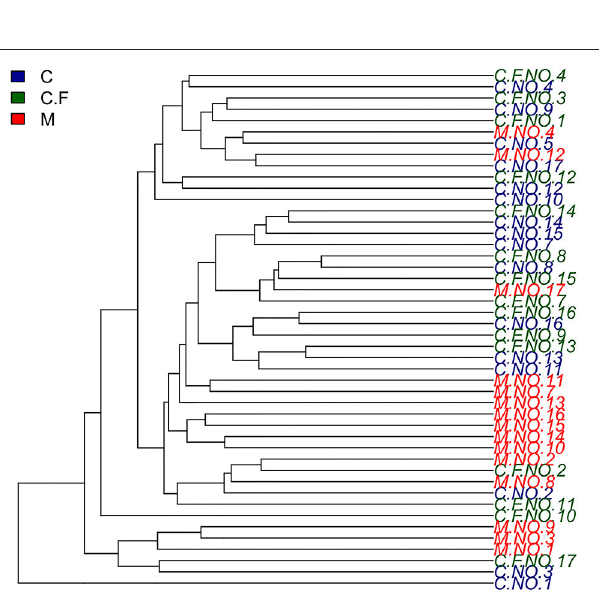
FIGURE 4 | Hierarchical cluster Analyses shows a similarity plot based on OTUs table for all individuals using average and vegan as a cluster method. In this study twins number 4, 8, 12, 13, 14, and 16 were monozygotic